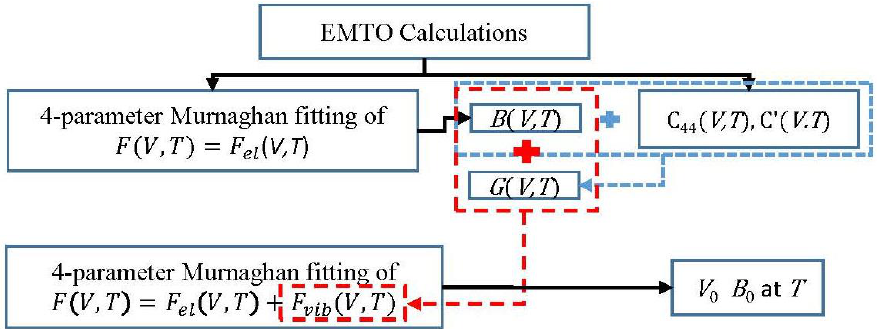
Figure 1. Computational scheme of equilibrium volume and bulk modulus.